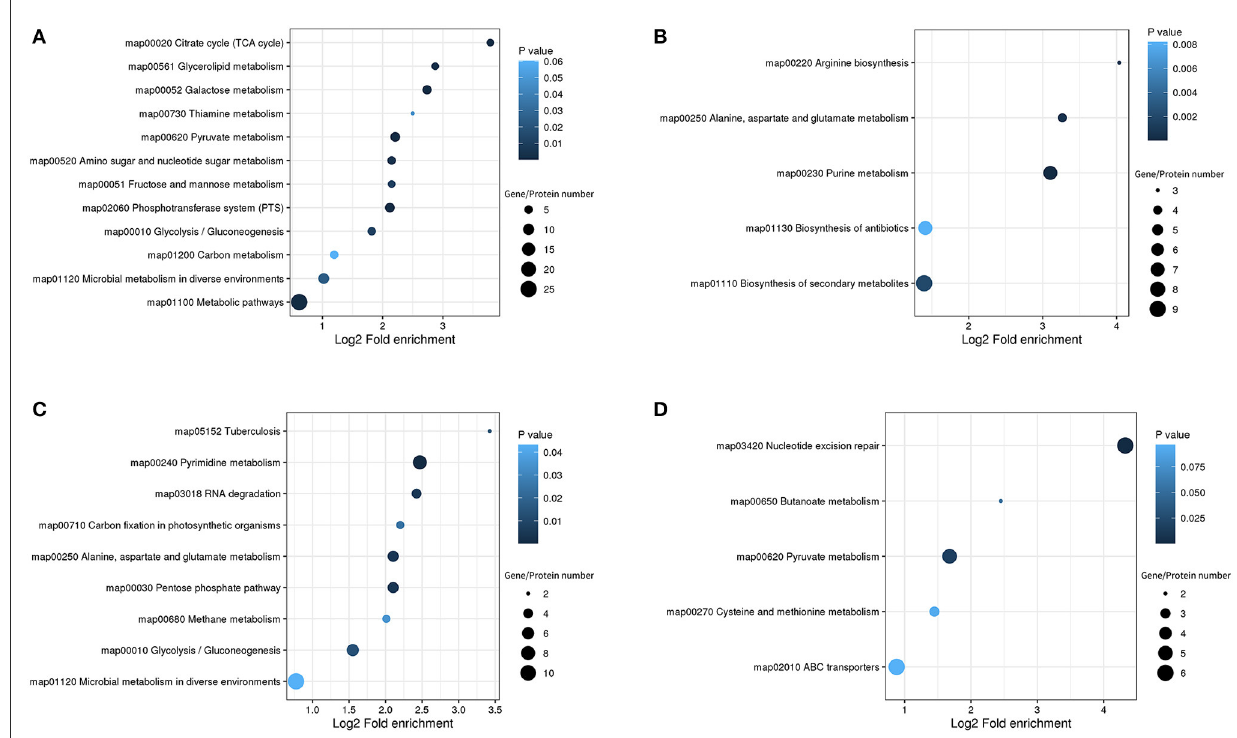
FIGURE4 KEGG pathway enrichment bubble diagrams in the DEGs/DEPs of L. paraplantarum RX-8 under co-culture. (A) Indicates KEGG pathway enrichment of upregulated genes and upregulated proteins, (B) indicates KEGG pathway enrichment of downregulated genes and downregulated proteins, (C) indicates KEGG pathway enrichment of upregulated genes and unchanged proteins, and (D) indicates KEGG pathway enrichment of downregulated genes and unchanged